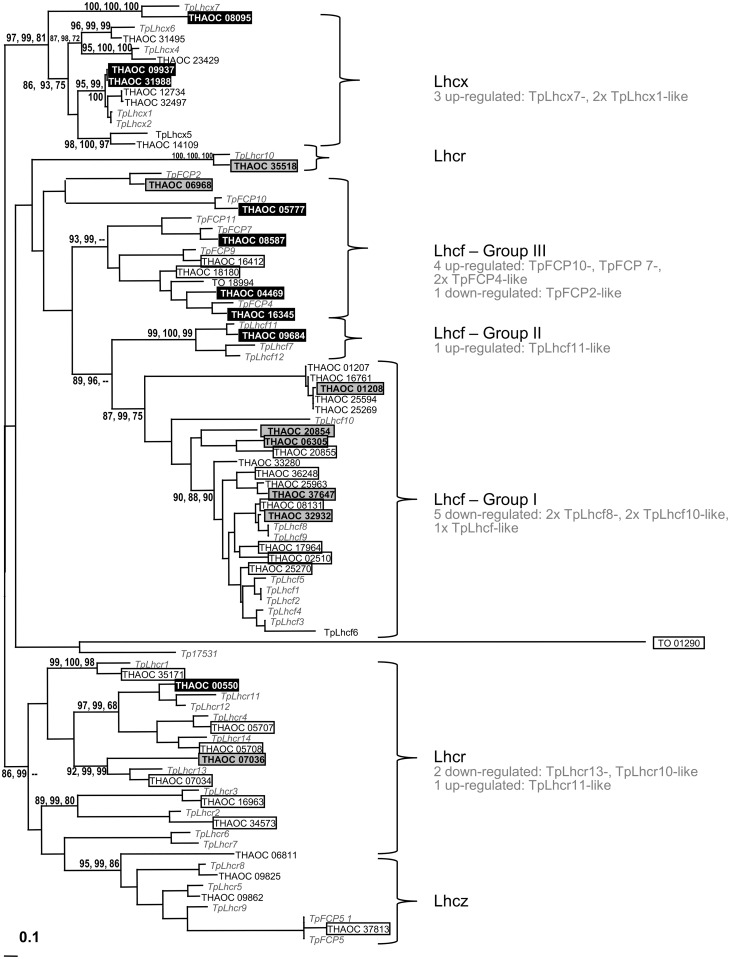
Phylogenetic tree of 48 predicted LHCs from the T. oceanica genome (CCMP 1005) aligned with 41 LHCs from T. pseudonana (CCMP 1335).Boxed THAOC LHCs have been identified at the protein level in this study. LHCs in grey shaded boxes with bold, black letters are significantly down-regulated and those in black shaded boxes with bold, white letters are significantly up-regulated in response to low Cu in TO03. The only significantly regulated LHC in TO05 is THAOC_08587 (up), which aligns closest to TpFCP7 (Table 2). Numbers on nodes are based on PhyML alertSH, aBayes, and standard bootstrap (100 replicates) and are expressed as percentages. Bootstrap values below 65% are not shown.